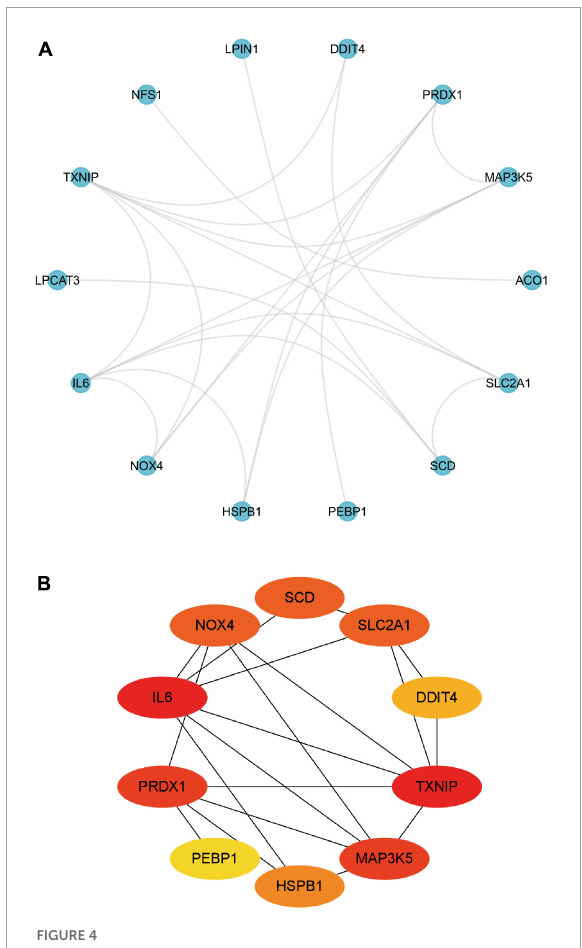
FIGURE4 PPI analysis of candidate differentially expressed ferroptosis-related genes. (A) PPI networks of candidate genes. (B) PPI subnetwork of the top 10 hub candidate genes. PPI, protein–protein